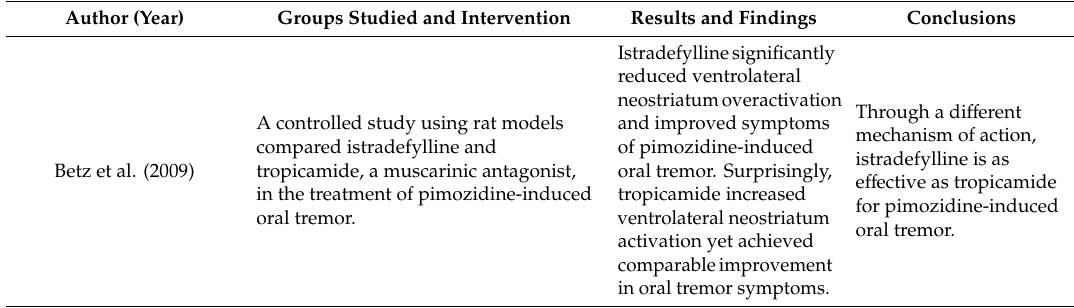
Table 2. Comparative